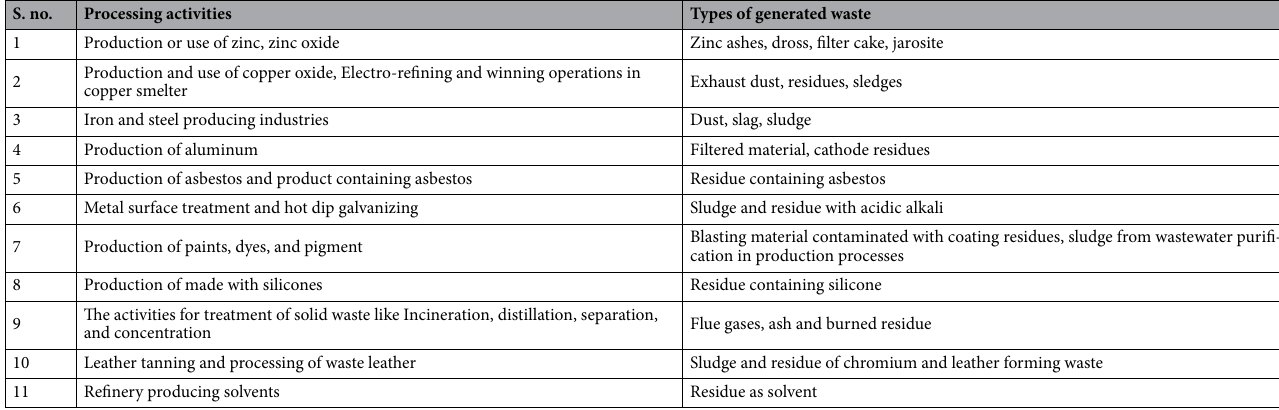
Table 2. Sources and types of generated recyclable hazardous wastes 26